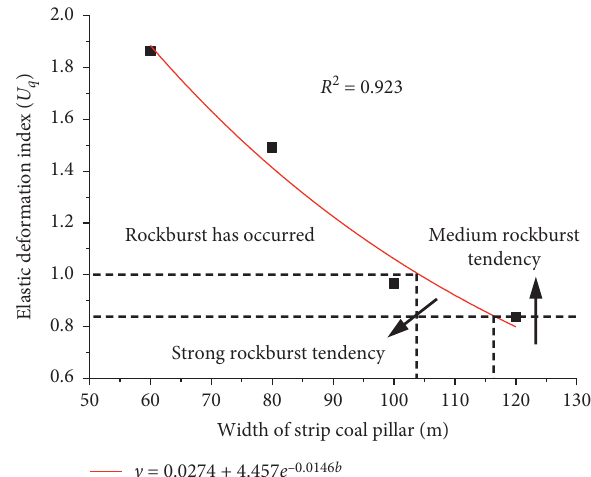
Figure 6: Fitting relationship of elastic deformation index of kernel zone and mining width.